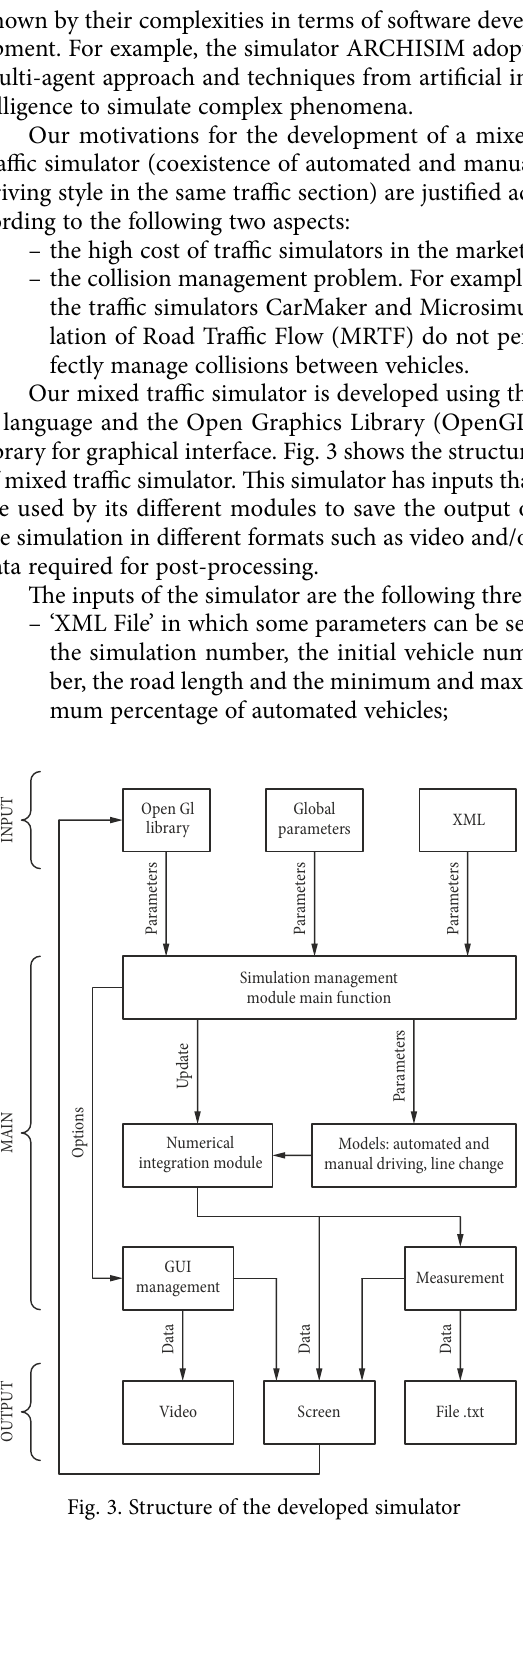
Fig. 3. Structure of the developed simulator